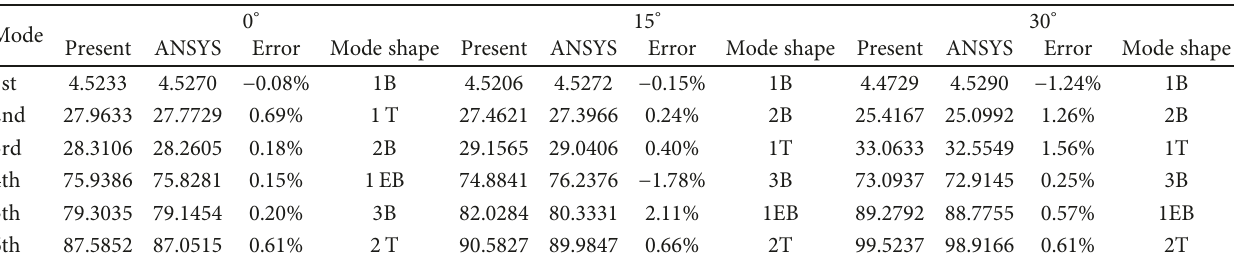
Table 5: Comparisons of nondimensional frequency parameters for the fi rst six modes of the FG sandwich blade ( l = 3 , h = 20 , n = 2 , and h = 1/2 l